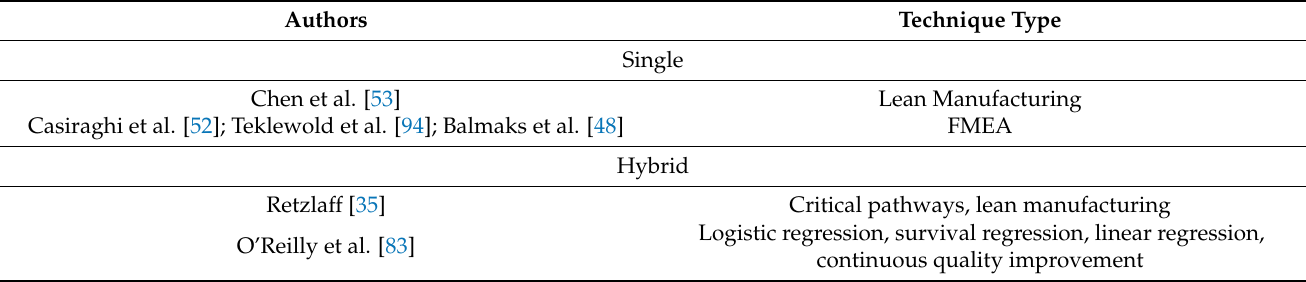
Table 3. Papers demonstrating the use of quality management techniques for augmenting the emergency department response to the COVID-19